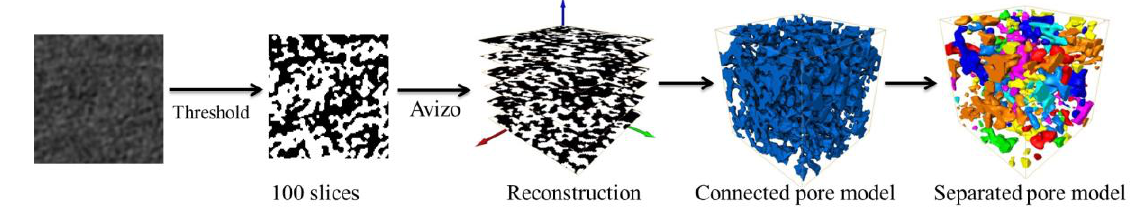
Figure 3. 3D pore structure reconstruction process.